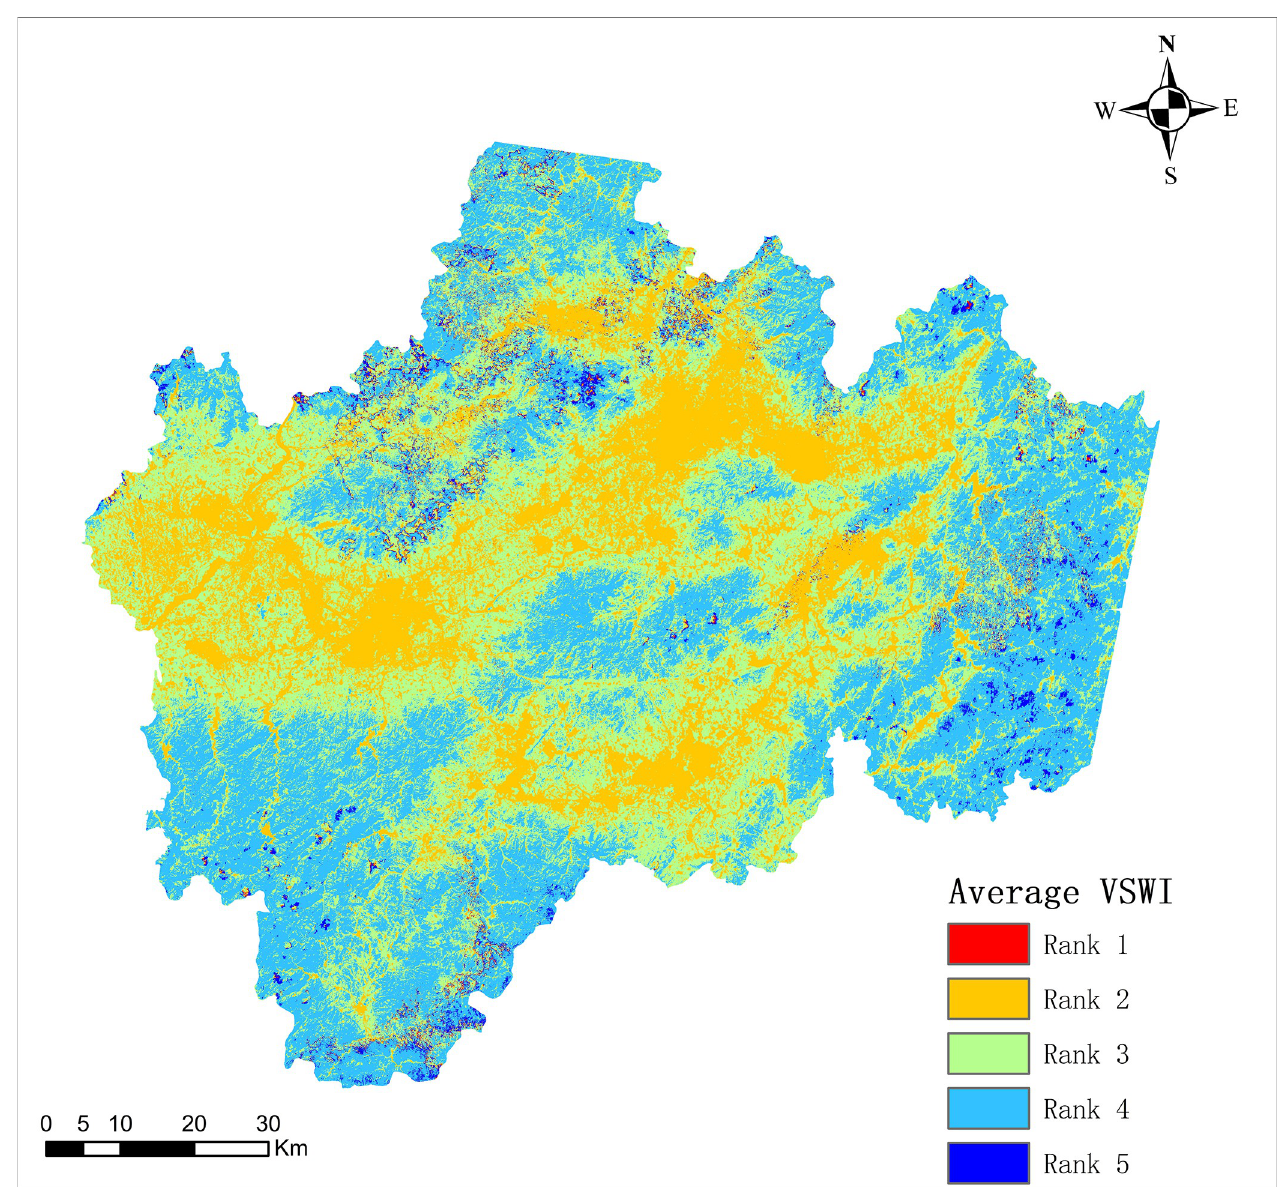
Fig 7. Average VSWI from 2005–2016.